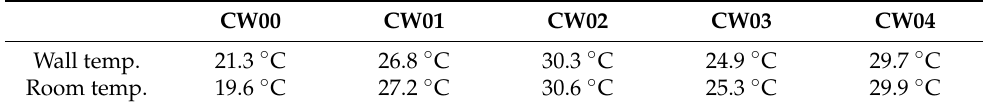
Table 7. The average temperatures resulted from numerical